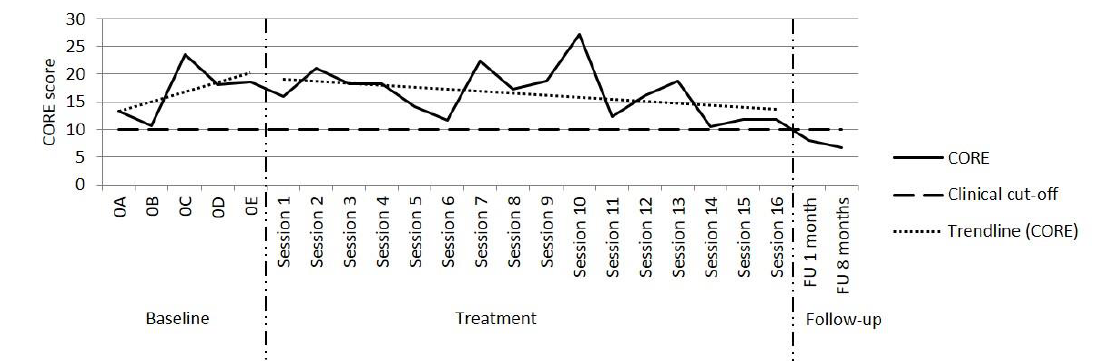
Figure 3: Giovanni’s weekly global distress (CORE) score